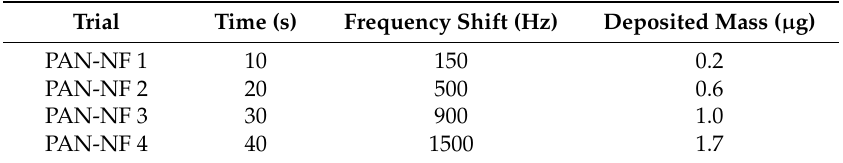
Table 1. Electrospinning parameters and frequency shift after coating with PAN